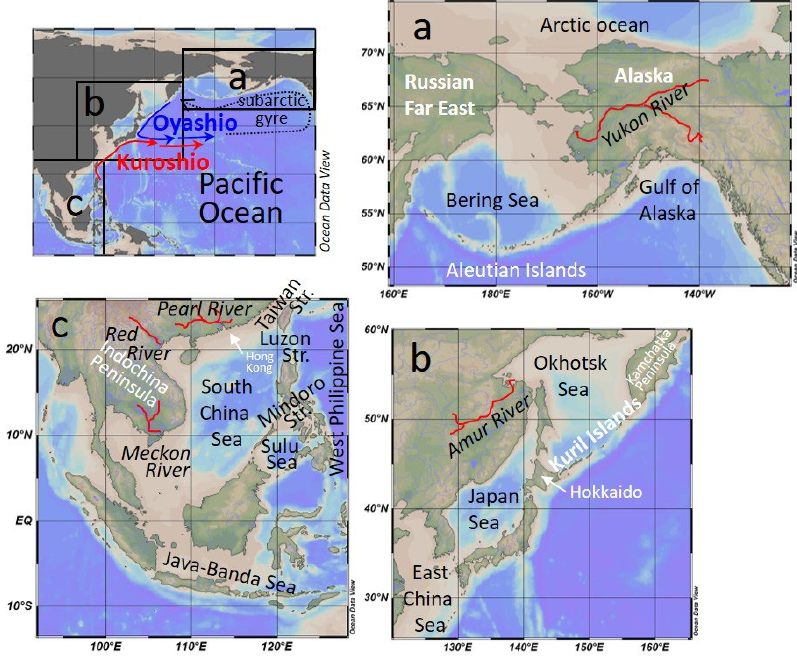
Figure 1. Maps of the ( a ) Bering, ( b ) Okhotsk, and ( c ) South China Seas (R. Schlitzer, Ocean Data View, http://odv.awi.de, 2018; accessed on 15 April